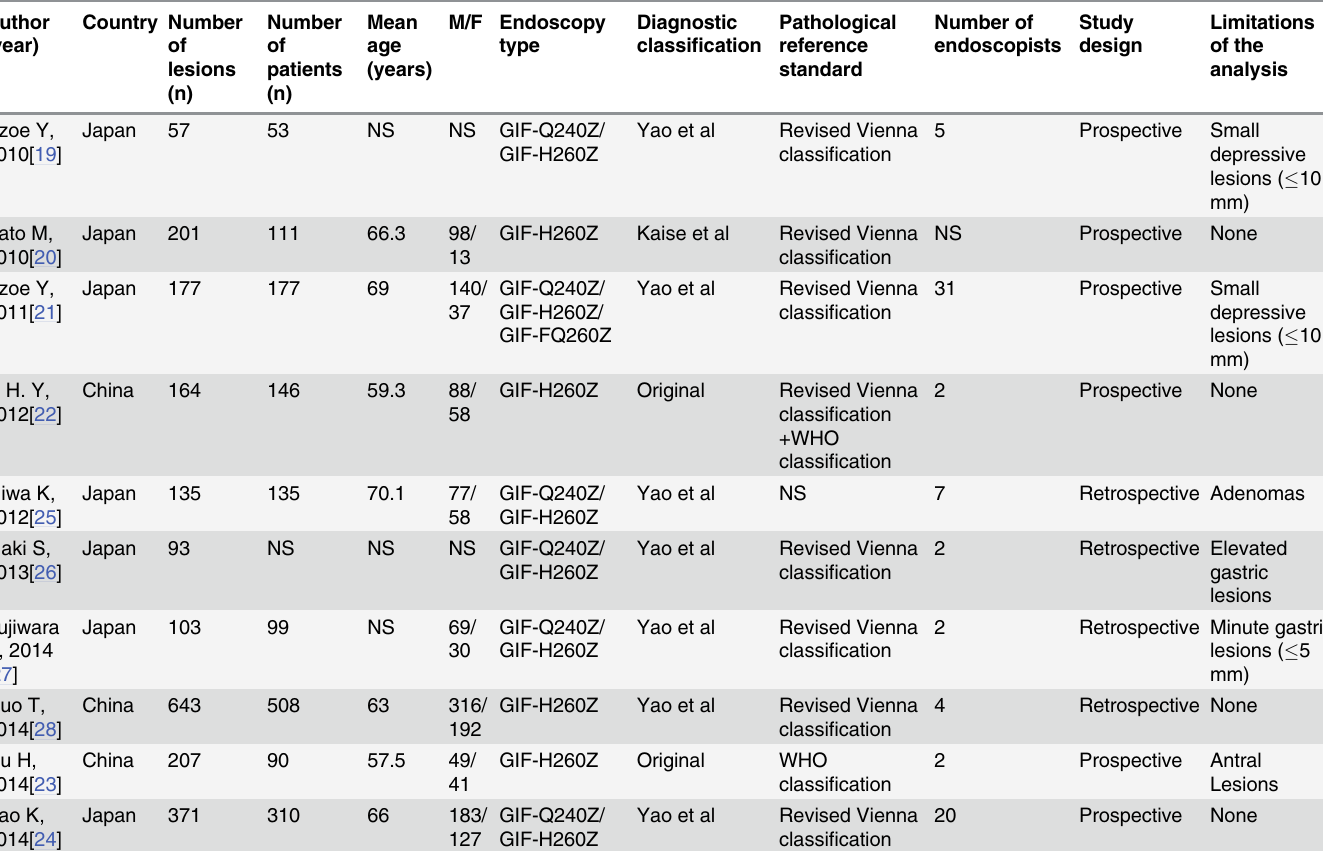
Table 1. Characteristics of the studies selected for the